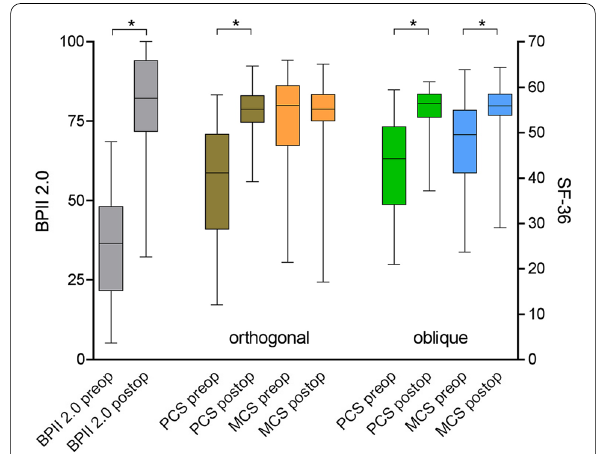
Fig. 1 Changes in PCS, MCS, and BPII 2.0 score values from pre- to postoperatively. PCS, physical component summary score; MCS, mental component summary score; obl, oblique; orth, orthogonal; BPII 2.0, Banff Patella Instablity Instrument 2.0